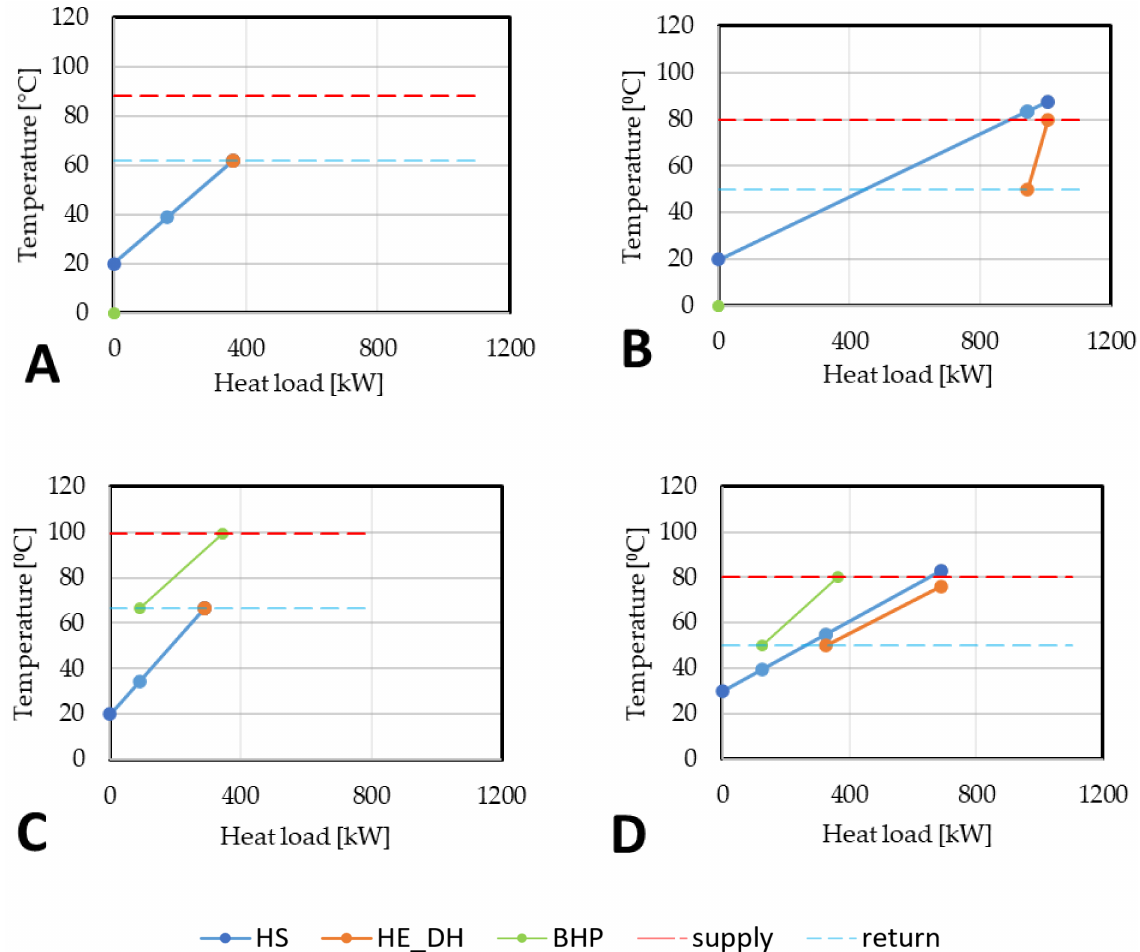
Figure 7. Possible pinch analysis results: ( A ) No waste heat utilized; ( B ) only heat exchanger utilization; ( C ) only heat pump utilization; ( D ) both heat exchanger and heat pump